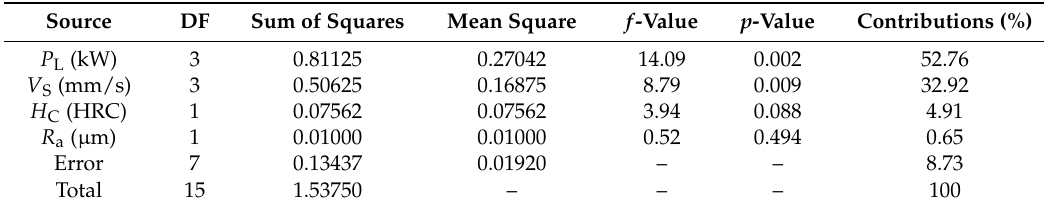
Table 2. ANOVA results for factors including R a .